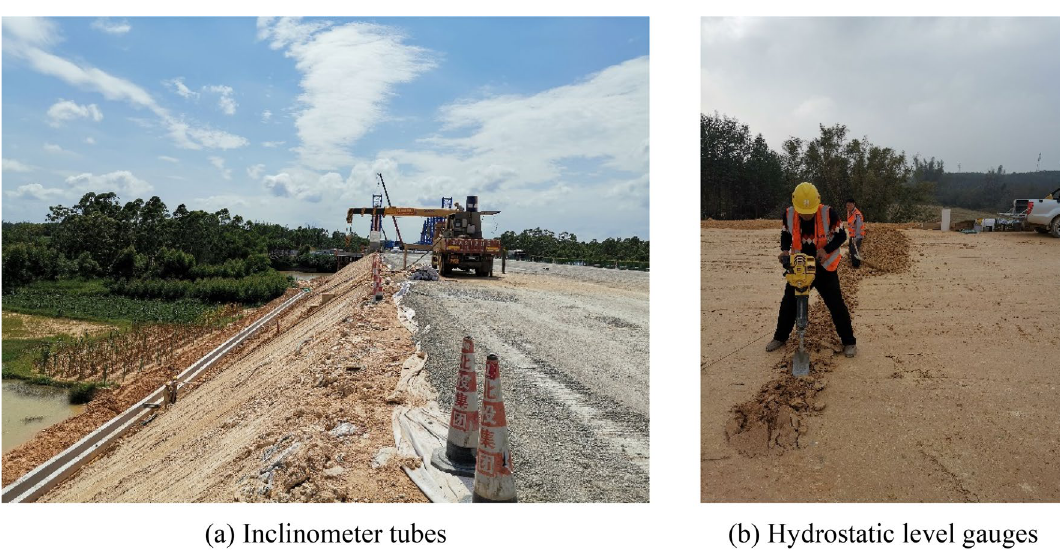
Figure 9. On-site monitoring instrument